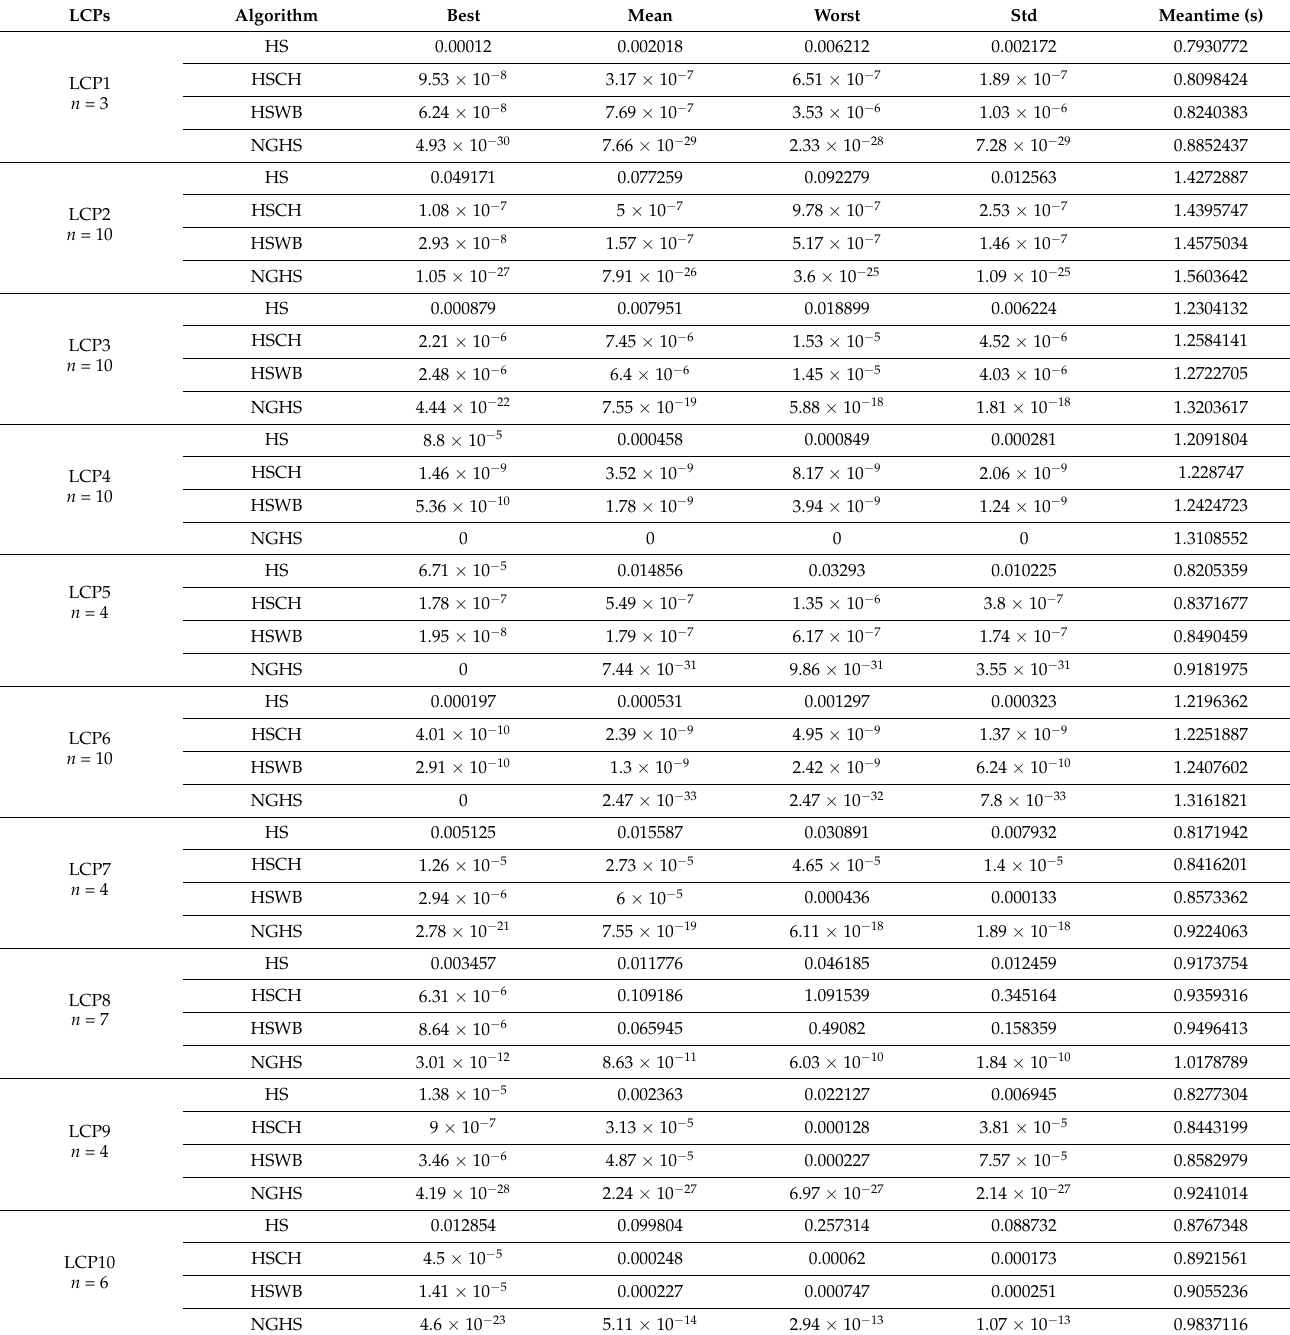
Table 1. Results for 10 runs on given